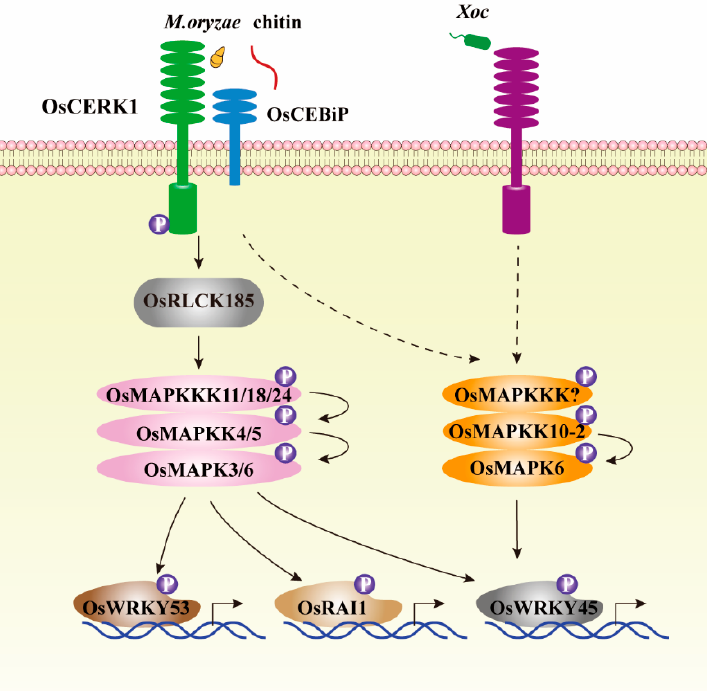
Figure 2. MAPK cascades are downstream of pattern recognition receptors complex and regulate rice immune response. After recognizing chitin or M. oryzae , rice pattern recognition receptors complex including OsCERK1 and OsCEBiP that localized at plasma membrane can phosphorylate OsRLCK185 to activate OsMAPKKK11/18/24-OsMAPKK4/5-OsMAPK3/6 cascades, leading to activation of numerous immune-related transcription factors, such as OsWRKY45, OsWRKY53, and OsRAI1 to initiate rice defense response [20,21,64,65]. Both fungal pathogen M. oryzae and bacterial pathogen Xoc can activate OsMAPKK10-2-OsMAPK6 cascade via unknown OsMAPKKK to